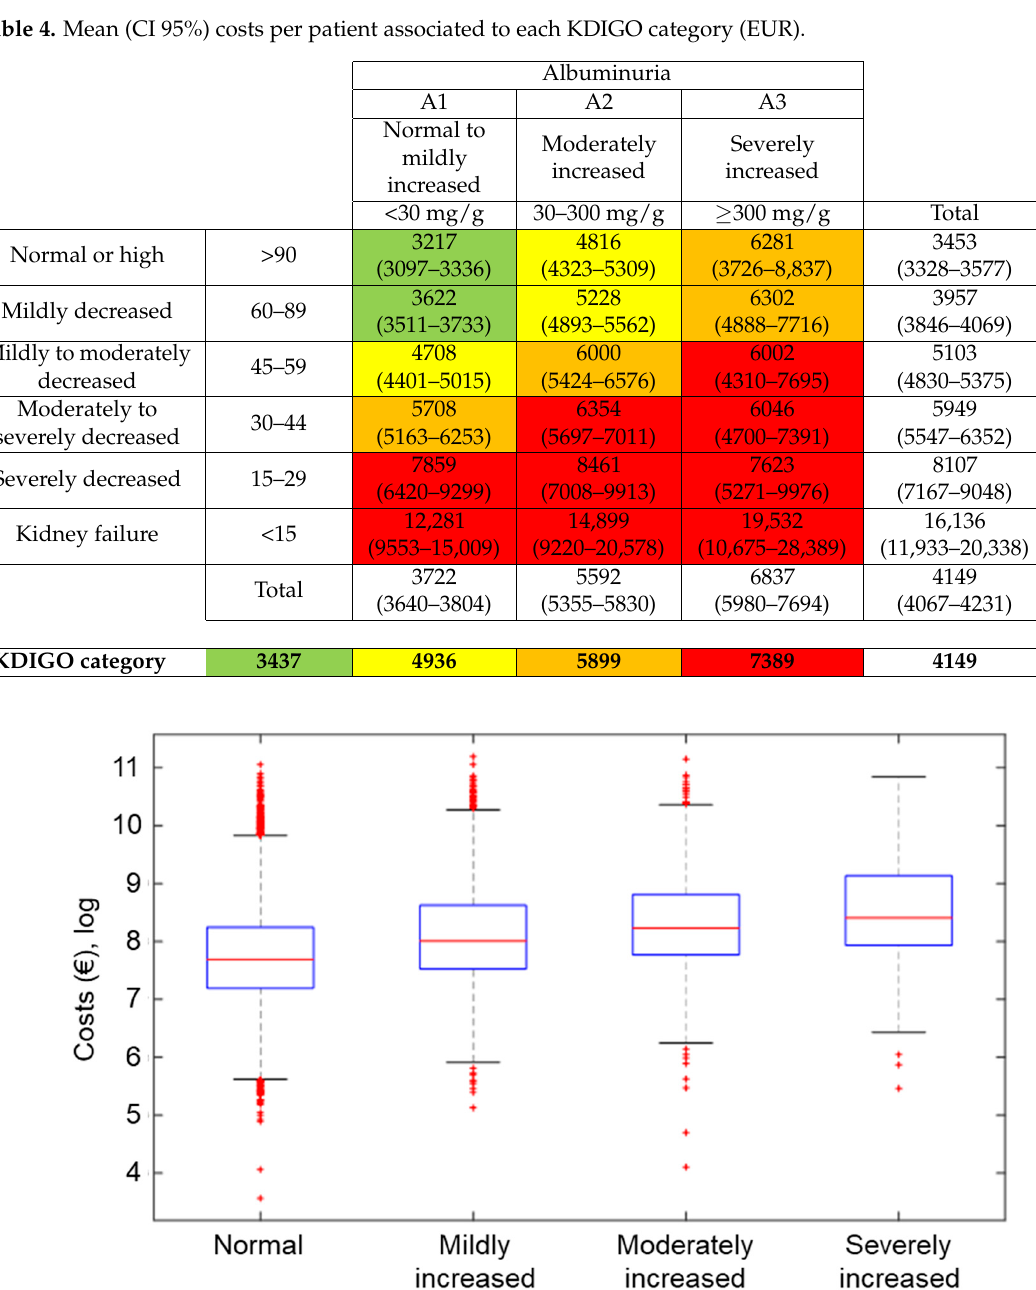
Figure 1. Box plots of the total mean costs (log scale) associated to KDIGO risk groups. The total costs (EUR) for each KDIGO category were highest in the low-risk group, inversely correlating with increasing risk (Figure 2). The patients at lower risk represented 54.8% of the total costs, those at moderately increased risk represented 24.5% of costs, those at highly increased risk represented 11.3% of costs, and those at very high risk represented 9.3% of costs. Taking into consideration the number of patients in each risk category, the mean cost per patient per year was EUR 3437 for low-risk patients, EUR 4936 for moderately increased risk patients, EUR 5899 for high-risk patients, and EUR 7389 for very high-risk patients. The total population costs per year were EUR 33,977,263, EUR 15,208,660, EUR 6,996,319, and EUR 5,785,465 for low, moderately increased, high and very high-risk patients,